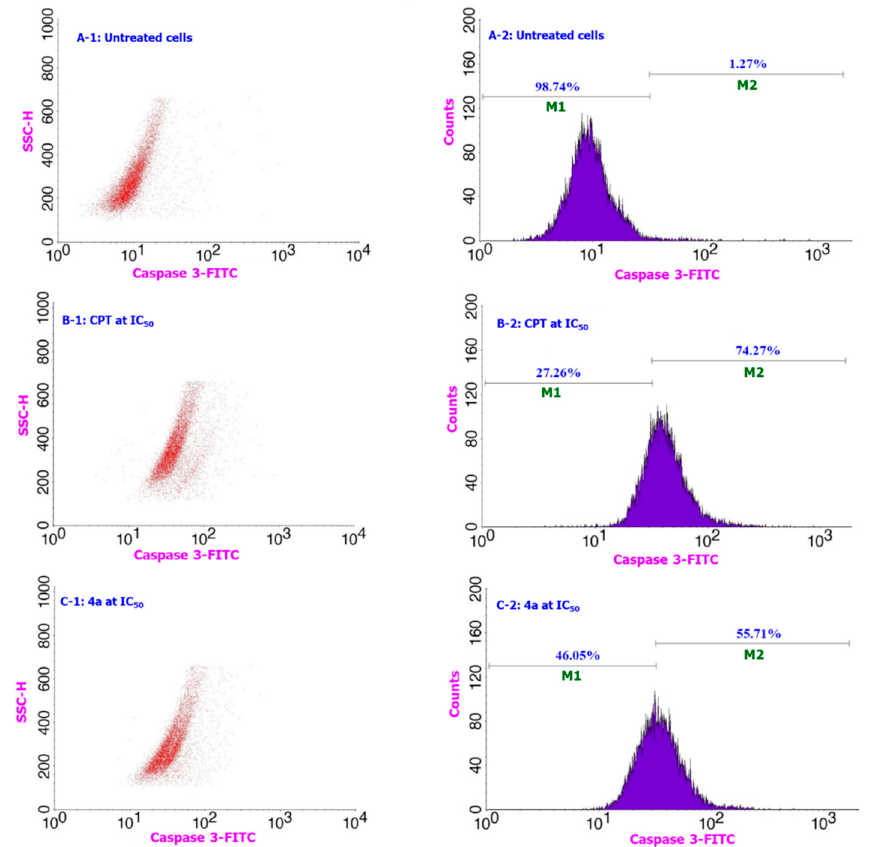
Figure 7. Comparison of compound 4a ( C-1 , C-2 ) induced caspase-3 activity in A549 cells with that of positive ( B-1 , B-2 ) and negative ( A-1 , A-2 ) controls over a 24 h incubation period.